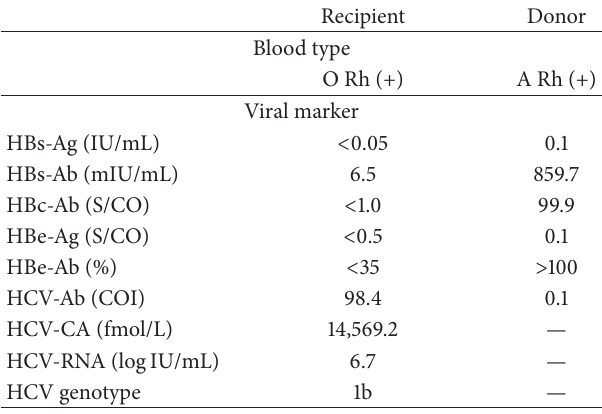
Table 1: Preoperative blood type, HBV and HCV marker status of the recipient and the living donor.